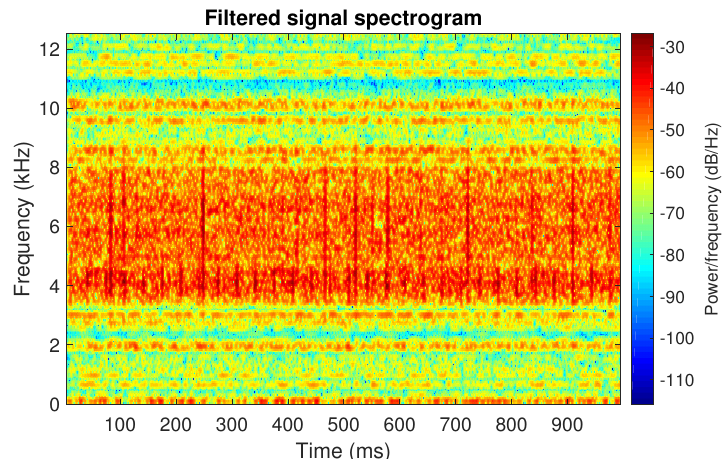
Figure 24. Spectrogram of filtered signal s 3 by Alpha selector.